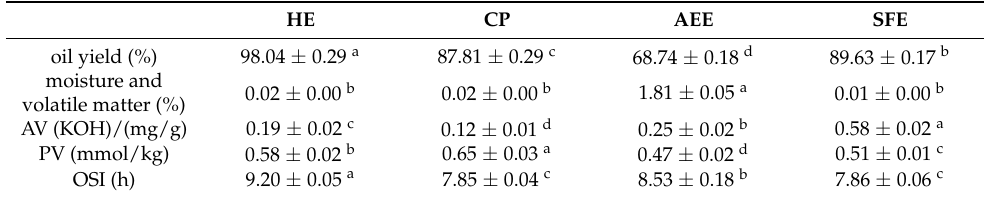
Table 2. The physicochemical properties of X. sorbifolia oil. HE CP AEE SFE oil yield (%) 98.04 ± 0.29 a 87.81 ± 0.29 c moisture and volatile matter